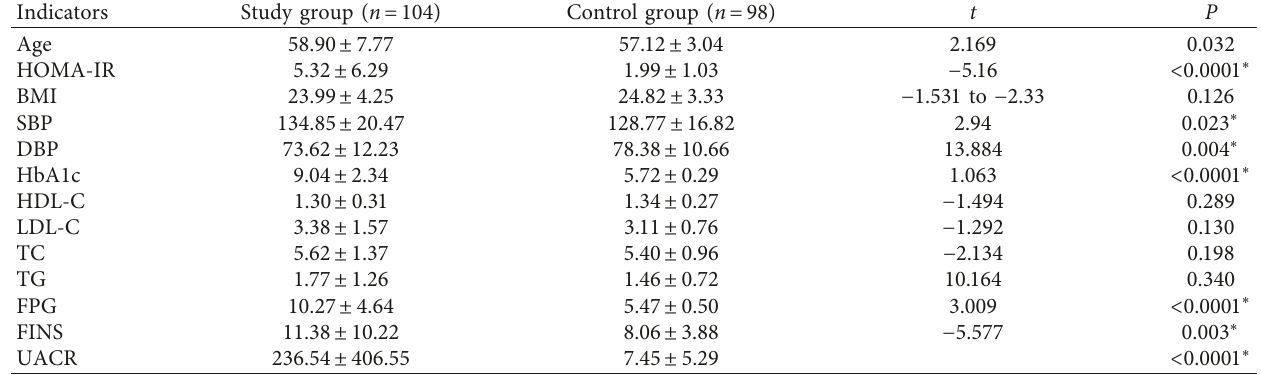
Table 1: Comparison of general information between two groups of patients ( x ± s ).